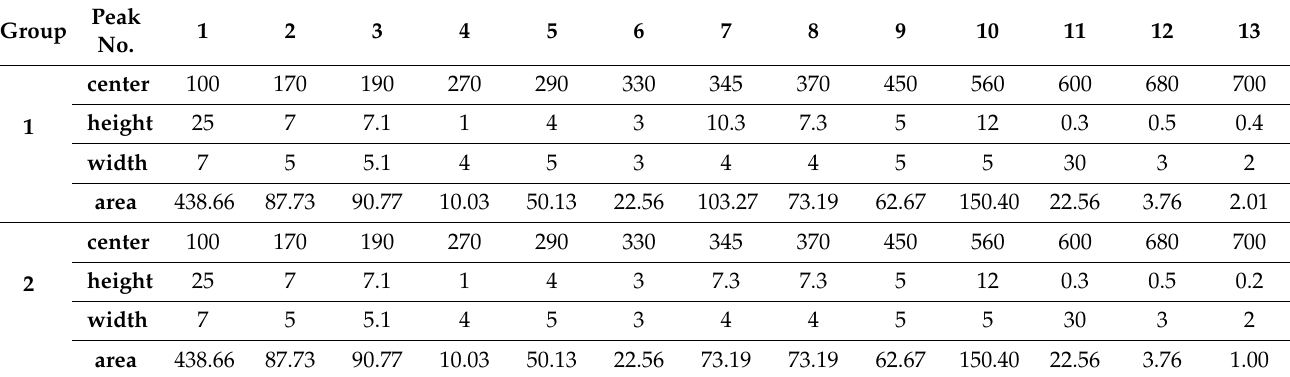
Table 1. Detailed information about chromatographic peaks (location, height, width, and area) contributing to template chromatographic signals used to generate two groups of samples. Peak Group No.